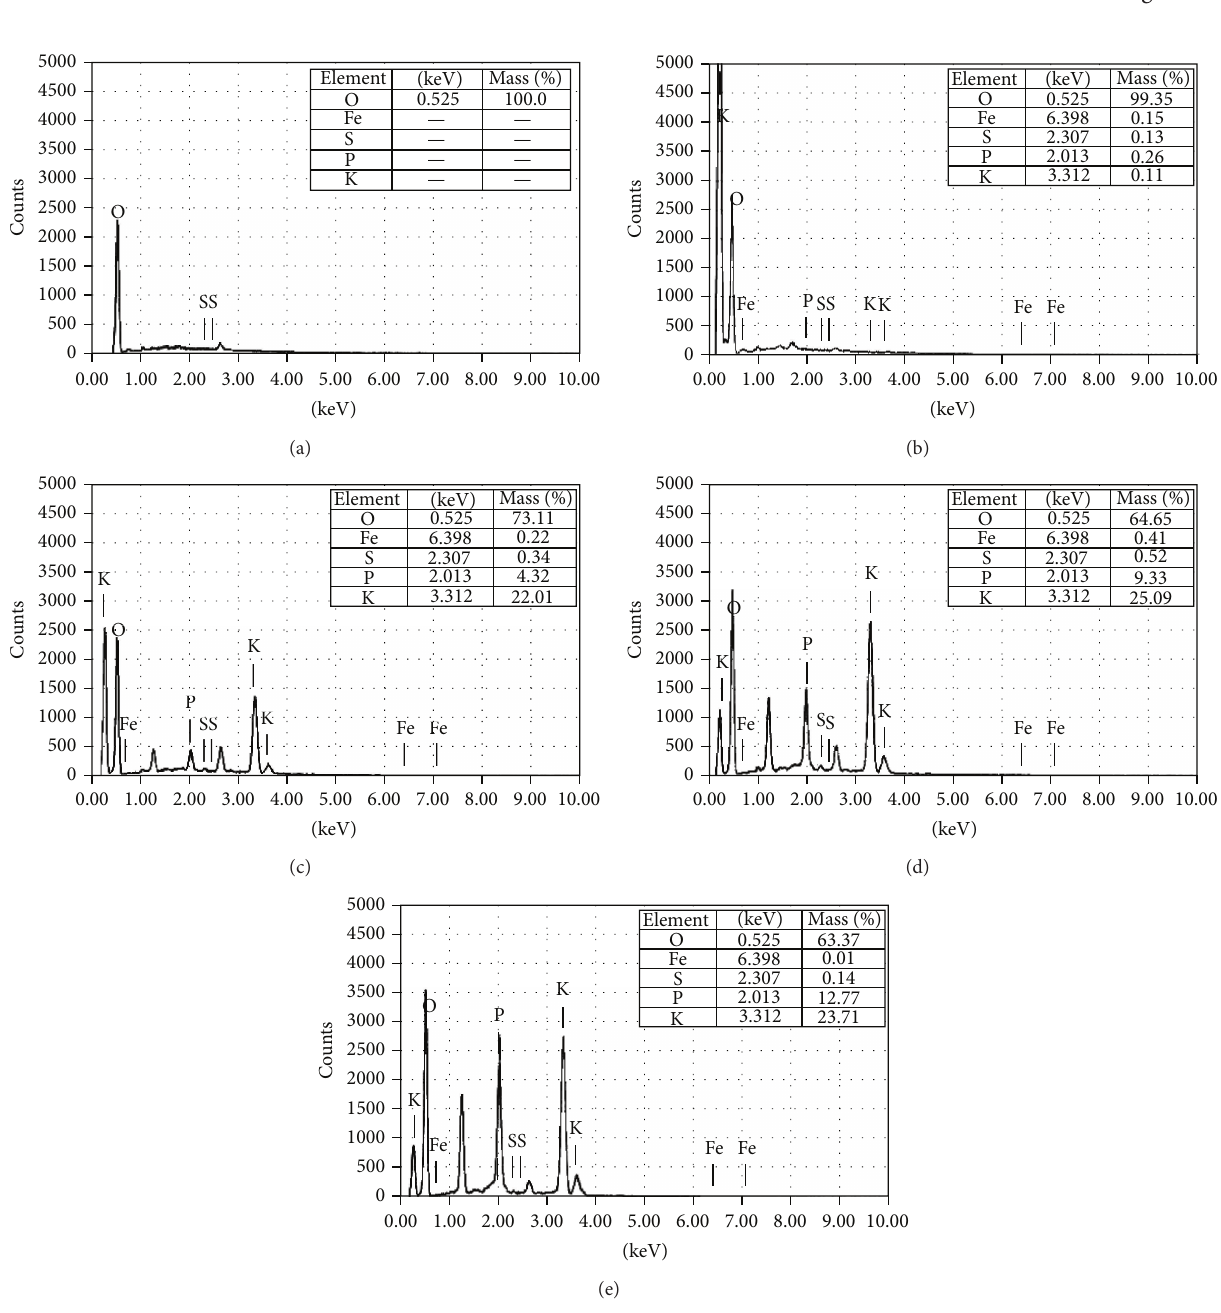
Figure 3: SEM (EDX) micrographs of (a) chitosan film, (b) chitosan-spinach blend film (95: 5), (c) chitosan-spinach blend film (90: 10), (d) chitosan-spinach blend film (85: 15), and (e) chitosan-spinach blend film (80: